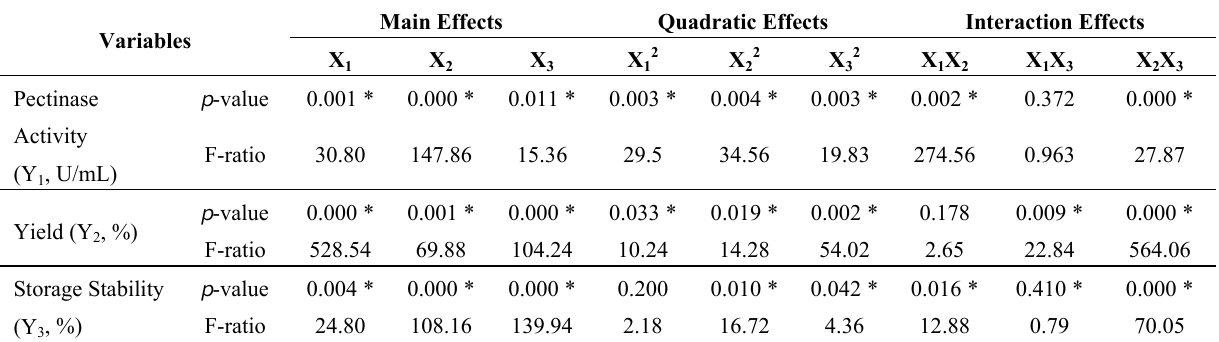
Table 2. F-ratio and p -value for each independent variable effect in the polynomial response surface models